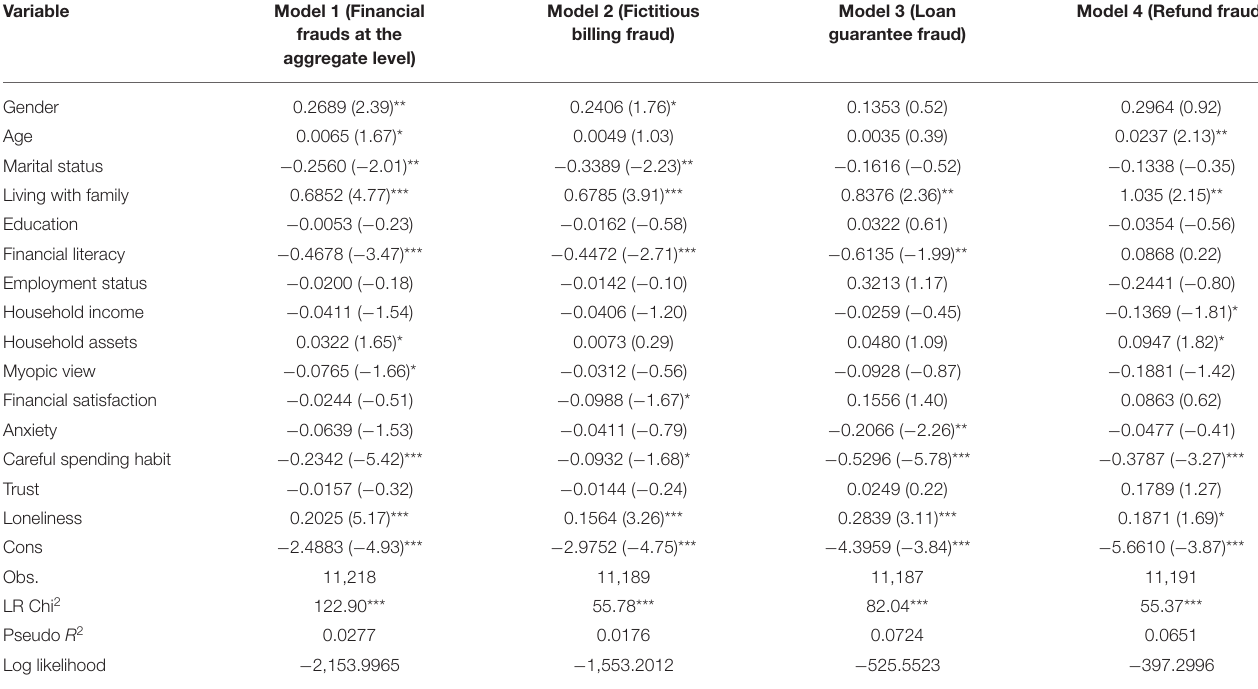
TABLE 4 | Regression